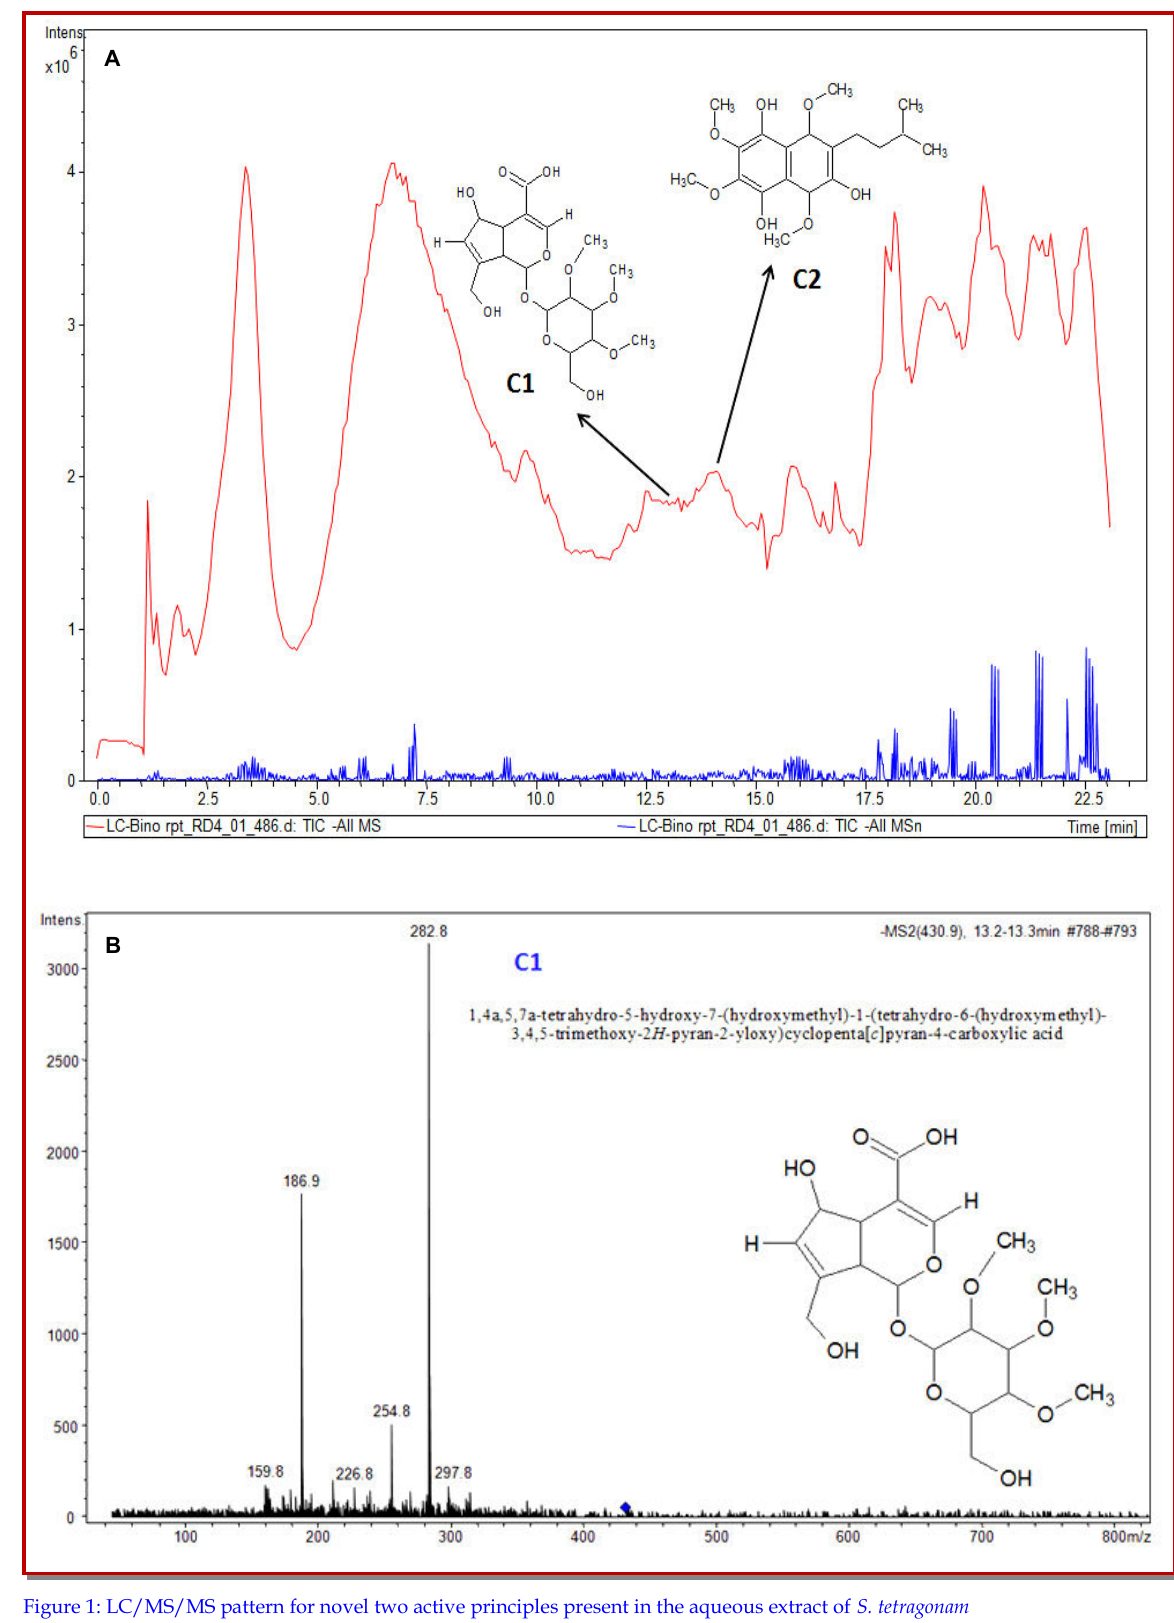
Figure 1: LC/MS/MS pattern for novel two active principles present in the aqueous extract of S.